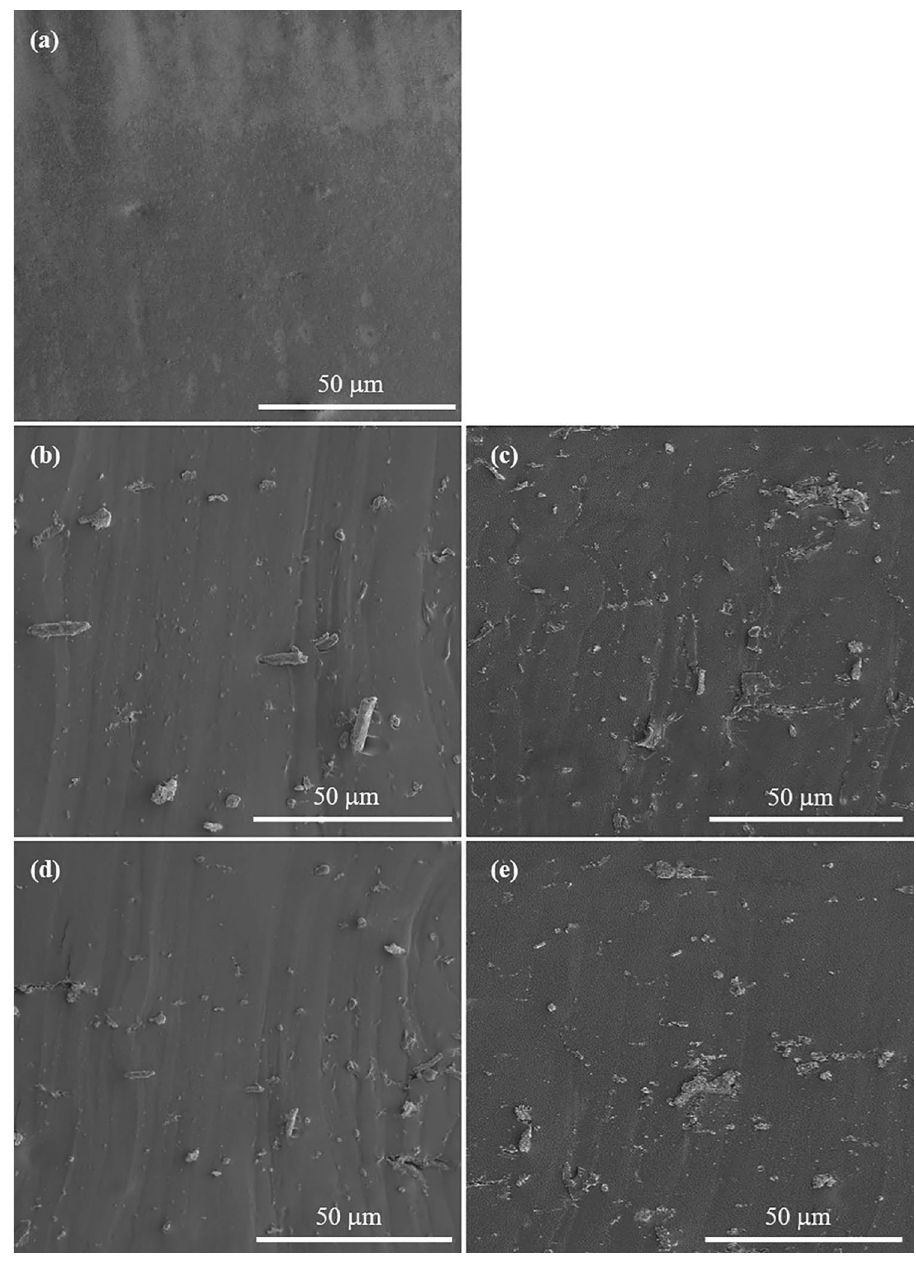
Figure 8. SEM images of the tensile fractured surfaces of: ( a ) Neat ENR, ( b ) ENR/CNC at 3 phr, ( c ) ENR/CNC at 5 phr, ( d ) ENR/M-CNC at 3 phr, and ( e ) ENR/M-CNC at 5